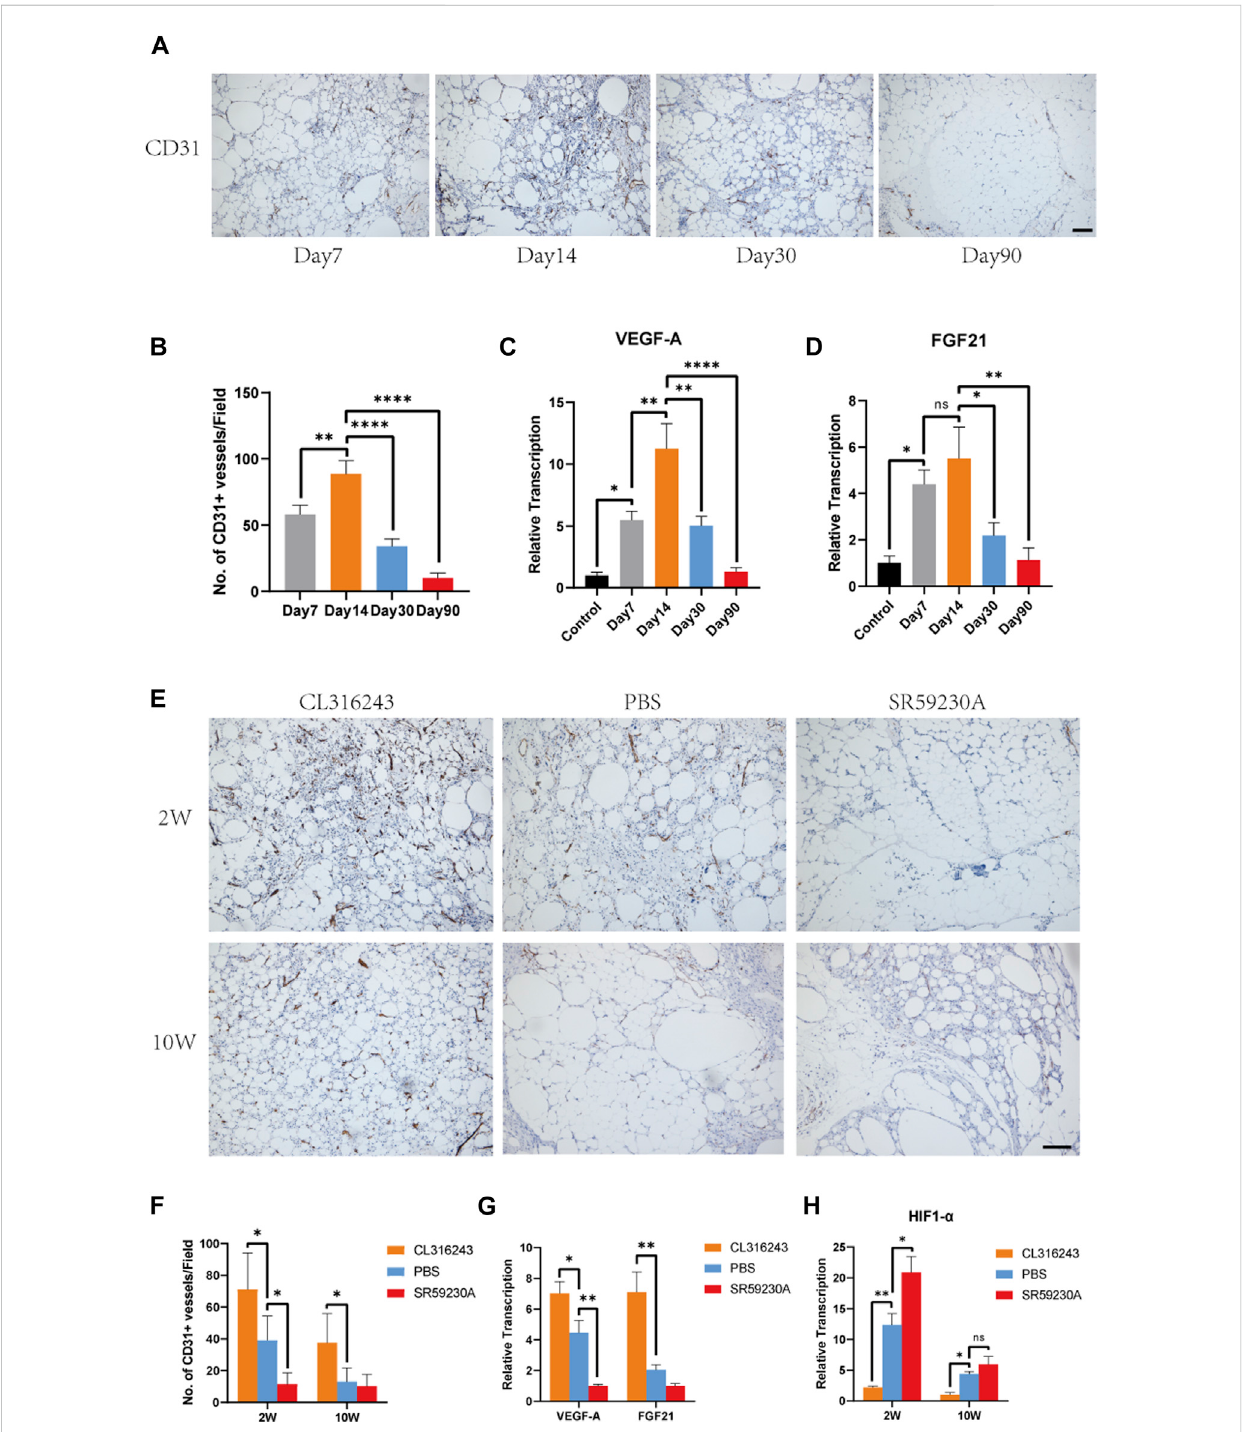
FIGURE 4 Beige adipocyte formation was associated with early angiogenesis and the production of VEGF-A and FGF21. (A) Angiogenesis of fat grafts was superior at day 14 than day 7, 30, and 90. (B) Quanti fi cation of CD31-positive cells at different time points. (C, D) Expression levels of angiogenic genes, VEGF-A and FGF21. (E) Angiogenesis in the fat grafts 2 weeks and 10 weeks after transplantation, identi fi ed using immunohistochemical staining for CD31. (F) Number of CD31+ vessels at week 2 and week 10. (G) Expression of the Vegfa and Fgf21 genes in the fat grafts at week 2, measured using quantitative RT-PCR. (H) Expression of HIF1- α associated with hypoxia at week 2 and week 10. (*p < 0.05; **p < 0.01; ****p < 0.0001). Scale bar = 50 μ